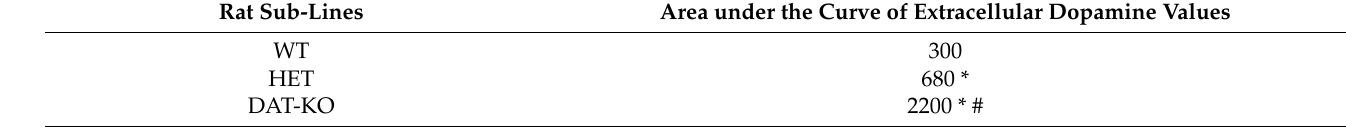
Table 17. Extracellular dopamine increases in the nucleus accumbens shell of WT, HET and DAT-KO rats during sexual activity in the fifth copulatory test with a receptive female